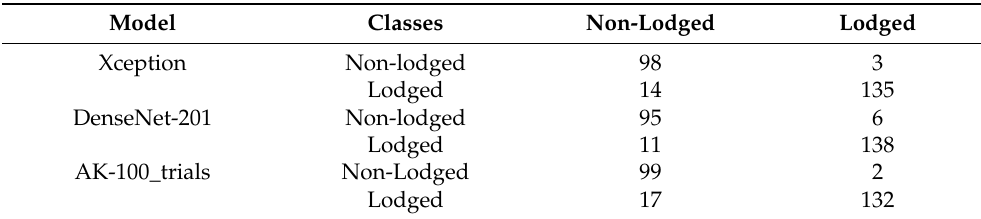
Table 3. Confusion matrices for the test set for the best models from transfer learning and AutoML.